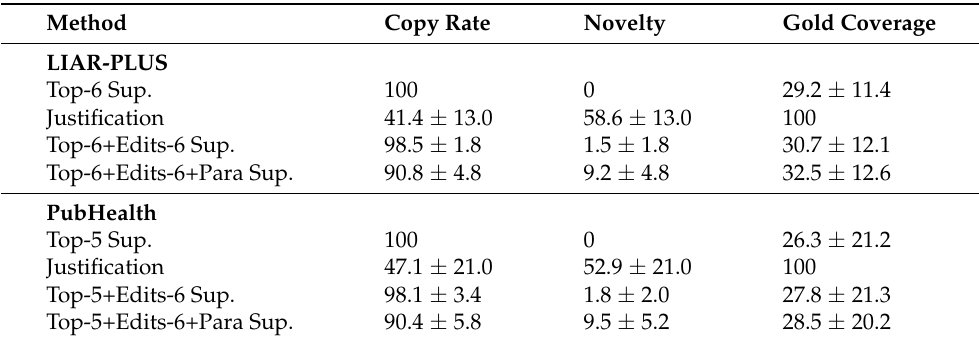
Table A5. Copy rate from the Ruling Comments, Novelty w.r.t the Ruling comments, and Coverage % of words in the explanation that are found in the